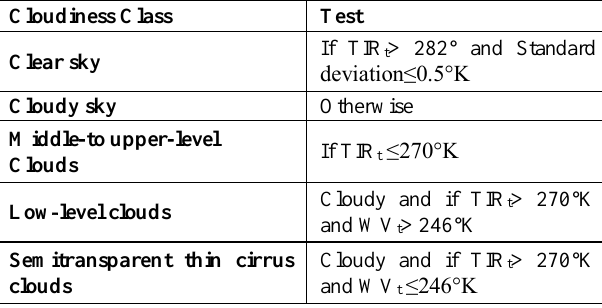
Table 1. Roca Cloud Classification Scheme used in IMSRA